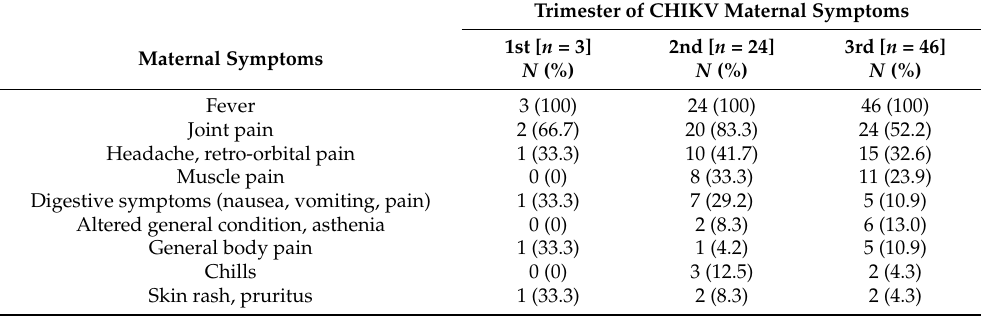
Table 2. Main symptoms of maternal CHIKV according to the trimester of pregnancy (pregCHIKV study N =